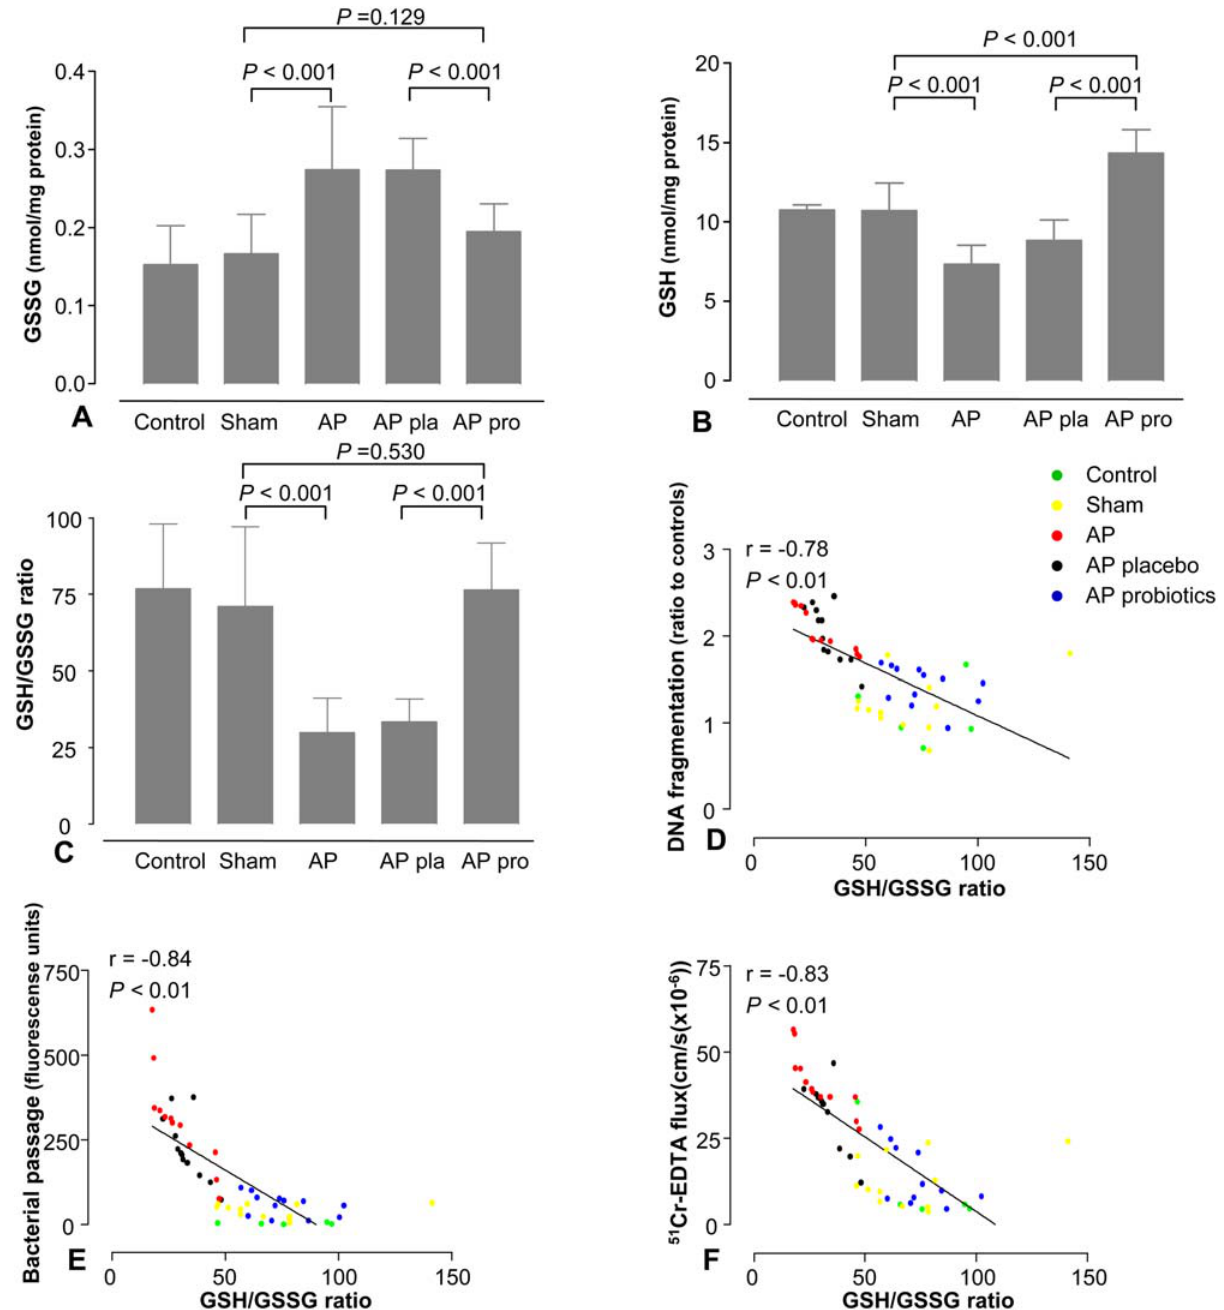
Figure 6. Probiotics enhanced mucosal glutathione levels. After 5 days of pre-treatment with placebo (pla, n=12) or probiotics (pro, n=12), rats were subjected to acute pancreatitis (AP, n=12), a sham-procedure (n=12) or not operated (control, n=5). Six hours after induction of the AP or sham-procedure, mucosal (A) oxidized glutathione levels (GSSG), (B) reduced glutathione levels (GSH) and (C) GSH/GSSG ratios were determined. The graphs show average ( 6 SD). Comparisons were performed using ANOVA followed by Tukey’s HSD. Correlation analyses revealed an inverse correlation between GSH/GSSG ratio and (D) DNA-fragmentation, (E) ileal permeability to Escherichia coli K12 and (F) 51 Cr-EDTA flux. Spearman’s rank correlation coefficients were computed for correlation analyses.